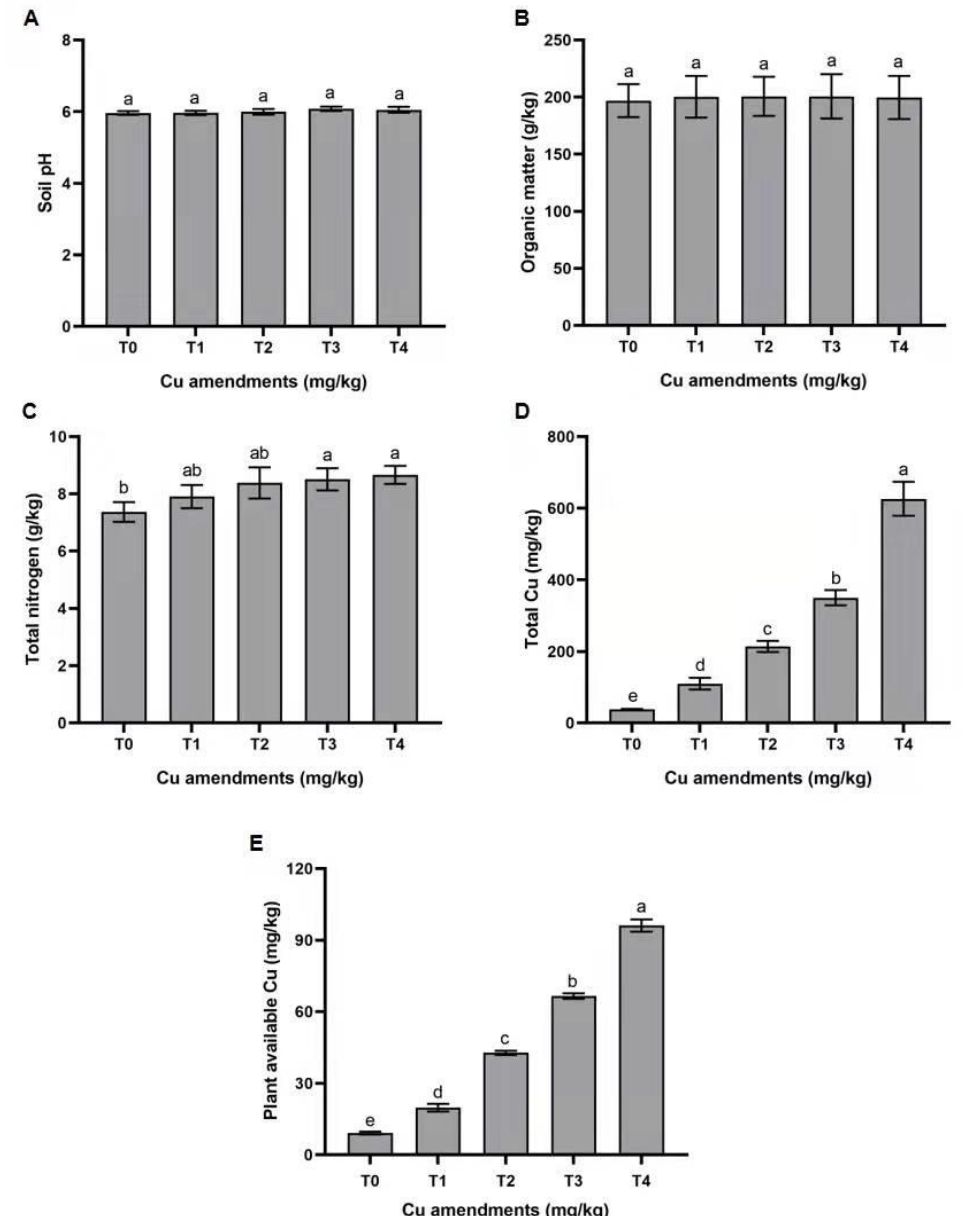
Figure 1. Variation in chemical properties and Cu concentrations (total and extractable) of soil treated with different Cu concentrations. ( A ) Soil pH; ( B ) organic matter (g/kg); ( C ) total nitrogen (g/kg); ( D ): total Cu (mg/kg); ( E ): plant available Cu (mg/kg). T0= control, T1 = 100, T2 = 200, T3 = 400 and T4 = 800 mg/kg. Each value is the mean of three replicates ± S.E. Bars with different letters are significantly different from each other (Tukey’s p < 0.05).